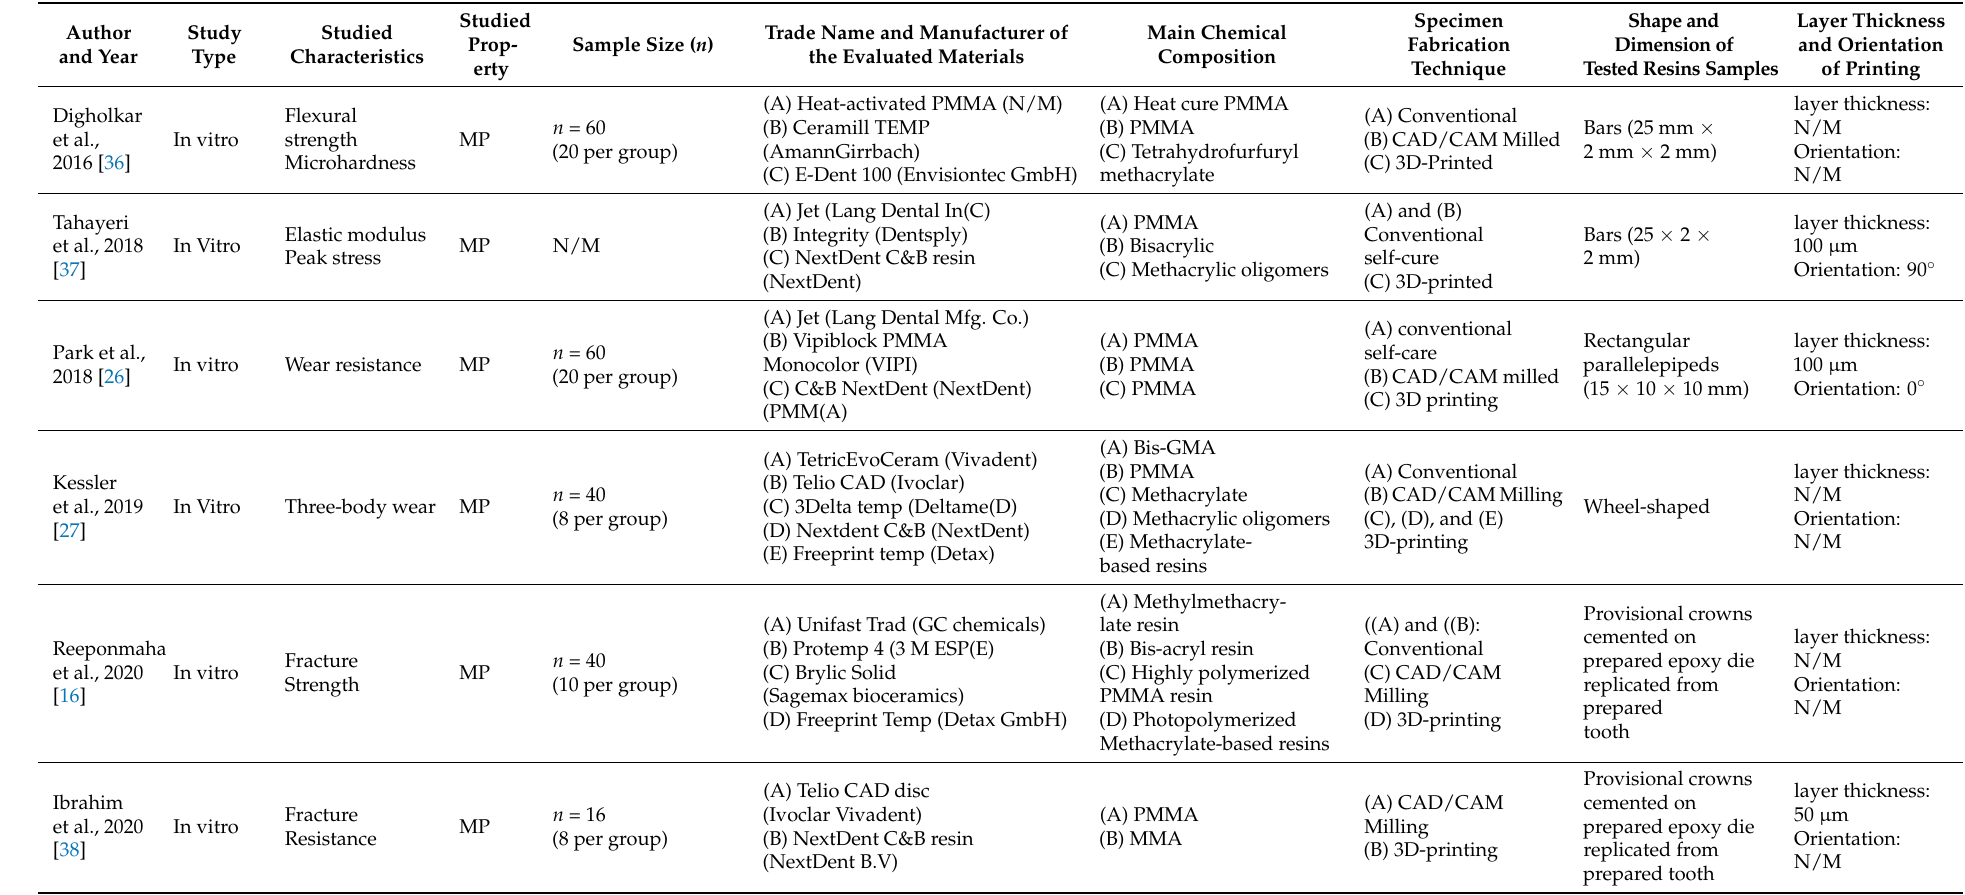
Table 3. Summary of the studies included in the systematic